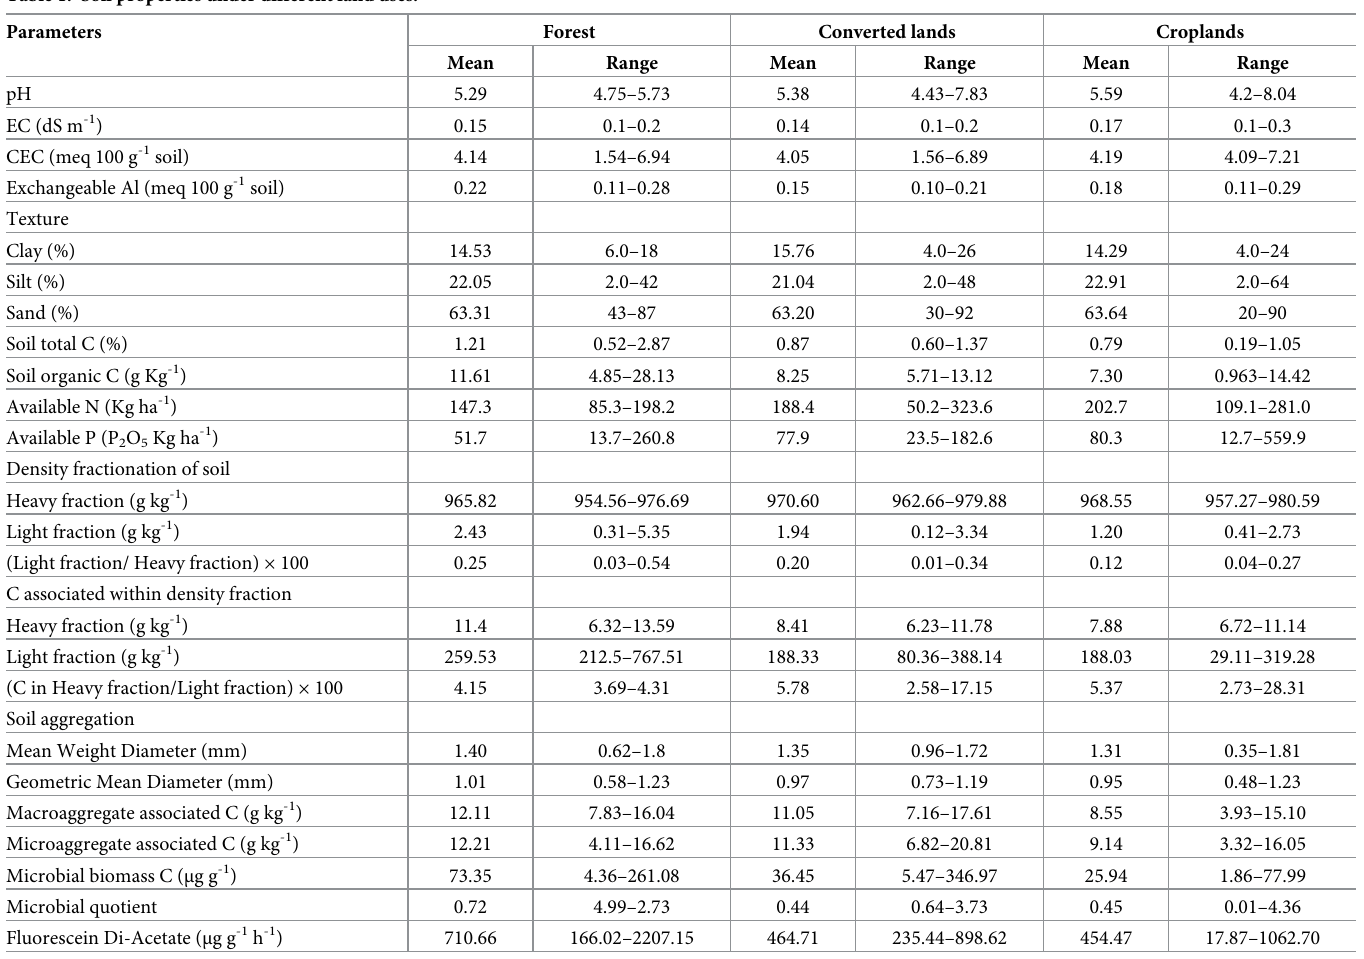
Table 1. Soil properties under different land